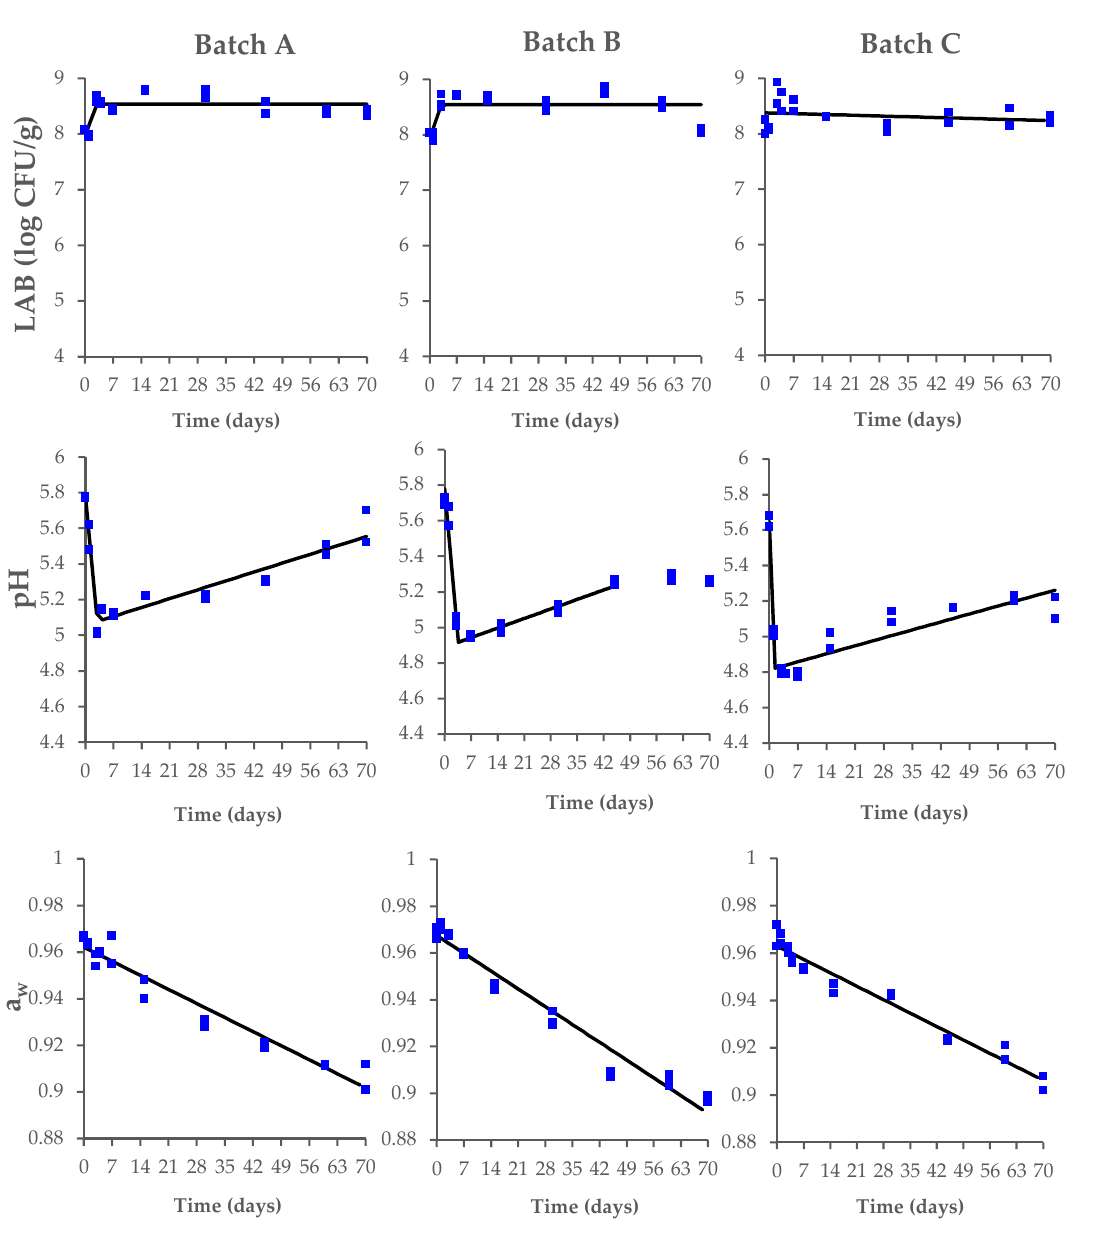
Figure 2. Changes in lactic acid bacteria (LAB) concentration, pH, and a w values, measured during the production process of Milano-type salami made from Batch A (basic recipe), Batch B (vegetable nitrates), and Batch C (synthetic nitrates/nitrites). The observed data (square symbols of two replicate samples for each batch) were interpolated by biphasic model. The interpolation (black line) is of visual interest only.